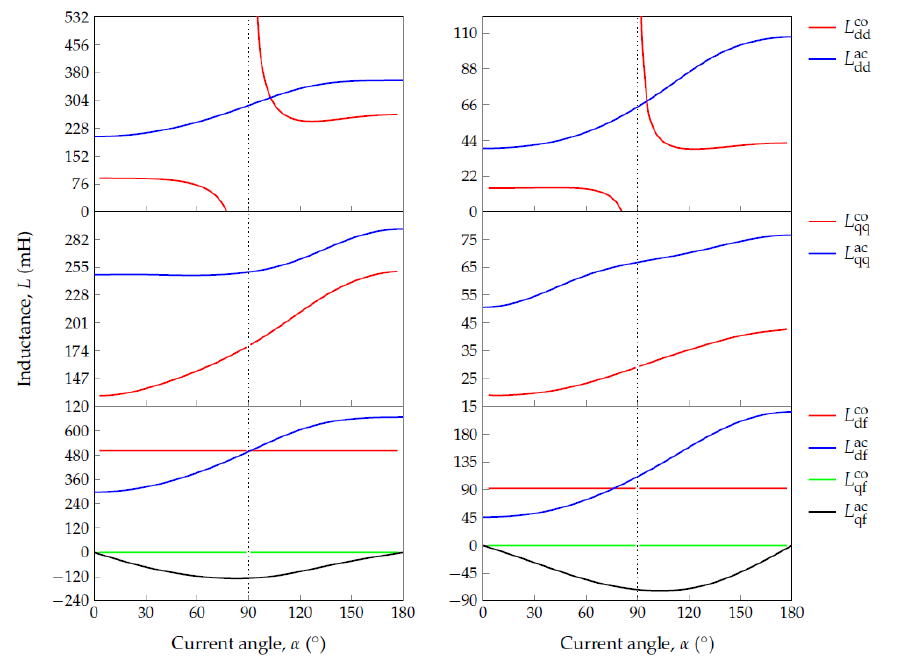
Figure 9. WF-FMM conventional and actual inductance characteristics of ( left ) WF-FSM and ( right ) DC-VRM at rated currents (phase and field) and different operating points defined by the current angle.